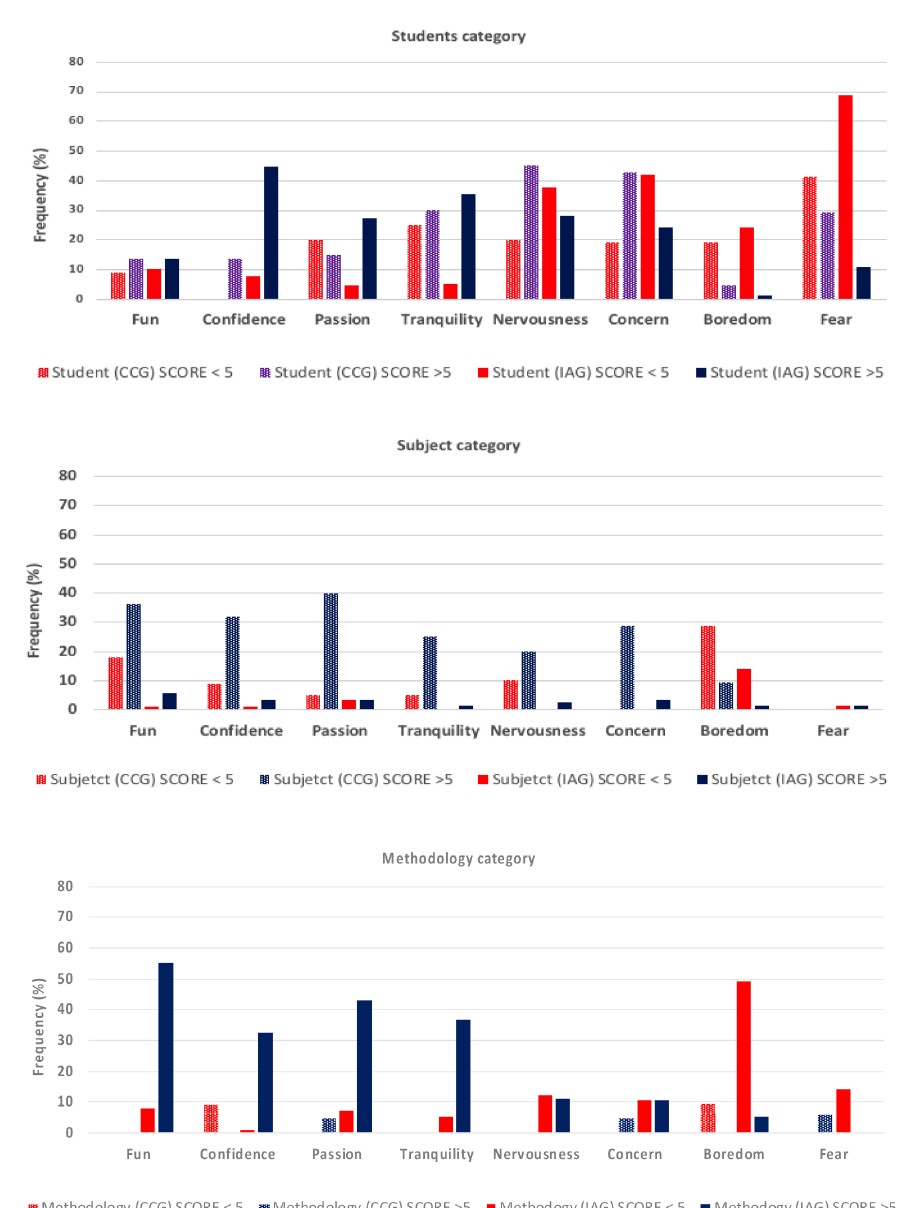
Figure 2. Frequency graph of the causes provided by the students to explain the scores given for each emotion. Each graph summarized the category related with the student, subject and learning